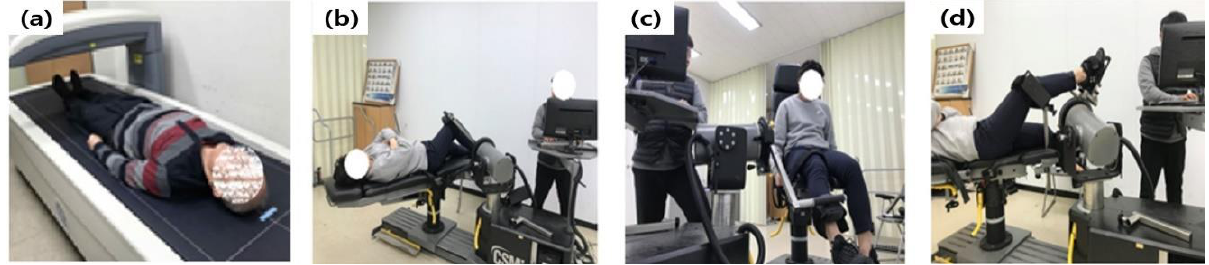
Figure 1. Measurements of BMD and maximum joint strength: ( a ) BMD, ( b ) hip, ( c ) knee, and ( d ) ankle joint.